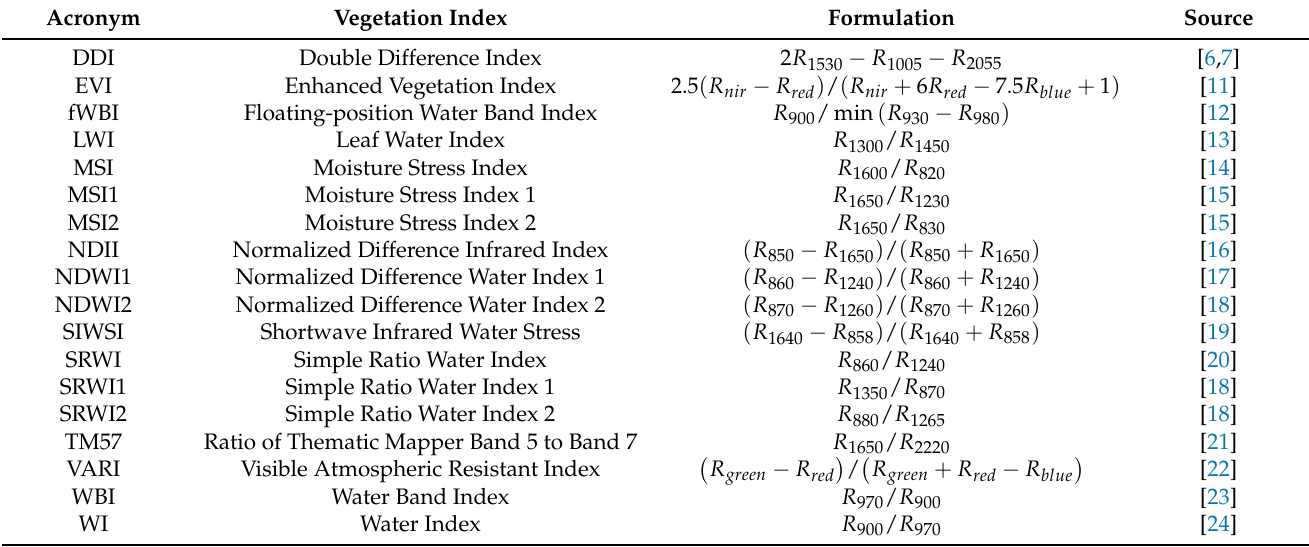
Table 2. Vegetation indices used in the estimation of moisture content, including their acronym, name, formulation and